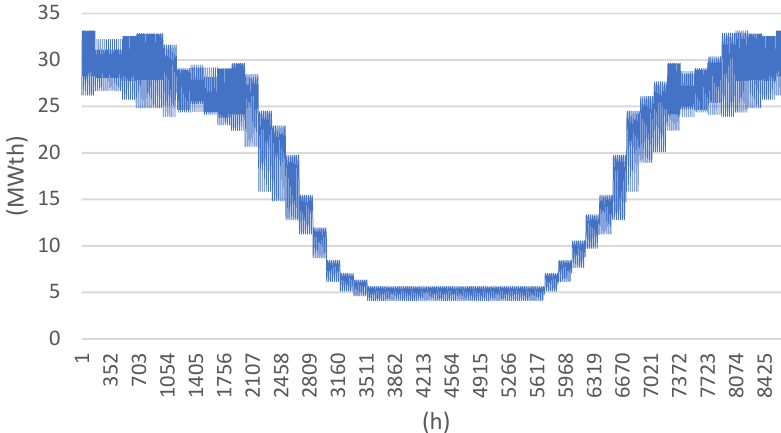
Figure 5. Heating energy demand.